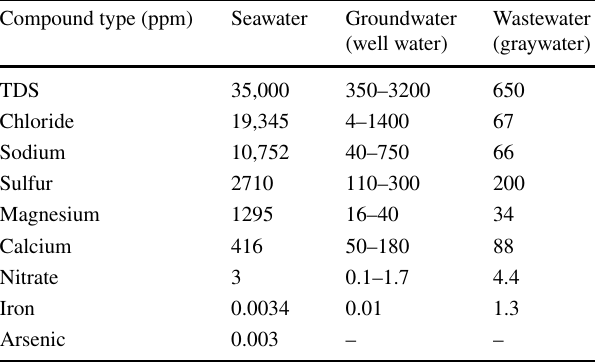
Table 2 Different compounds in water resources (Kucera 2019) Compound type (ppm)